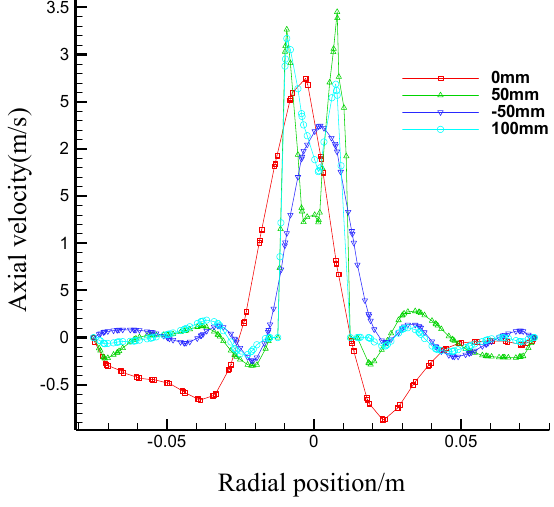
Figure 16. Axial velocity inside cyclone with different insertion depth of inner vortex finder.